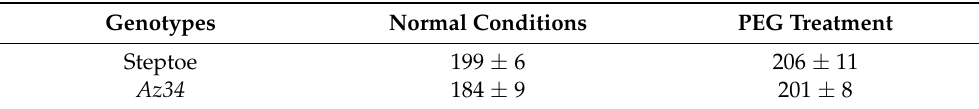
Table 1. The length of all seminal roots (mm) of Steptoe and Az34 grown under normal conditions and polyethylene glycol (PEG) treatment. Data are means ± SE of 50 replicates. No statistical differences were detected in these experiments.